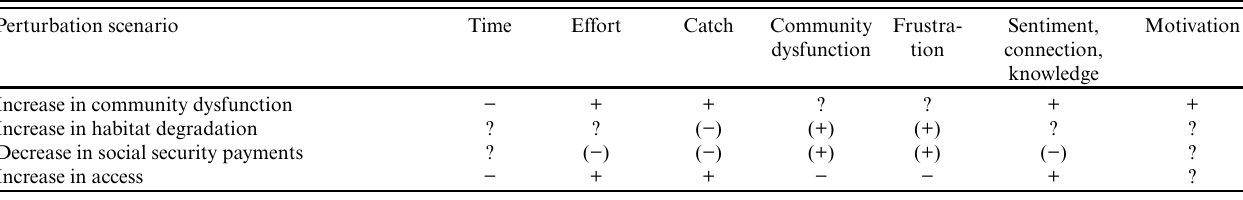
Table 5. Predictions of qualitative response of select variables in model B to four perturbation scenarios. Predicted responses in terms of direction of change (+, increase; −, decrease) in model variables; ambiguous predictions with a relatively high probability of sign determinacy (≥ 0.85) are enclosed in parentheses; and “?” denotes predictions with low